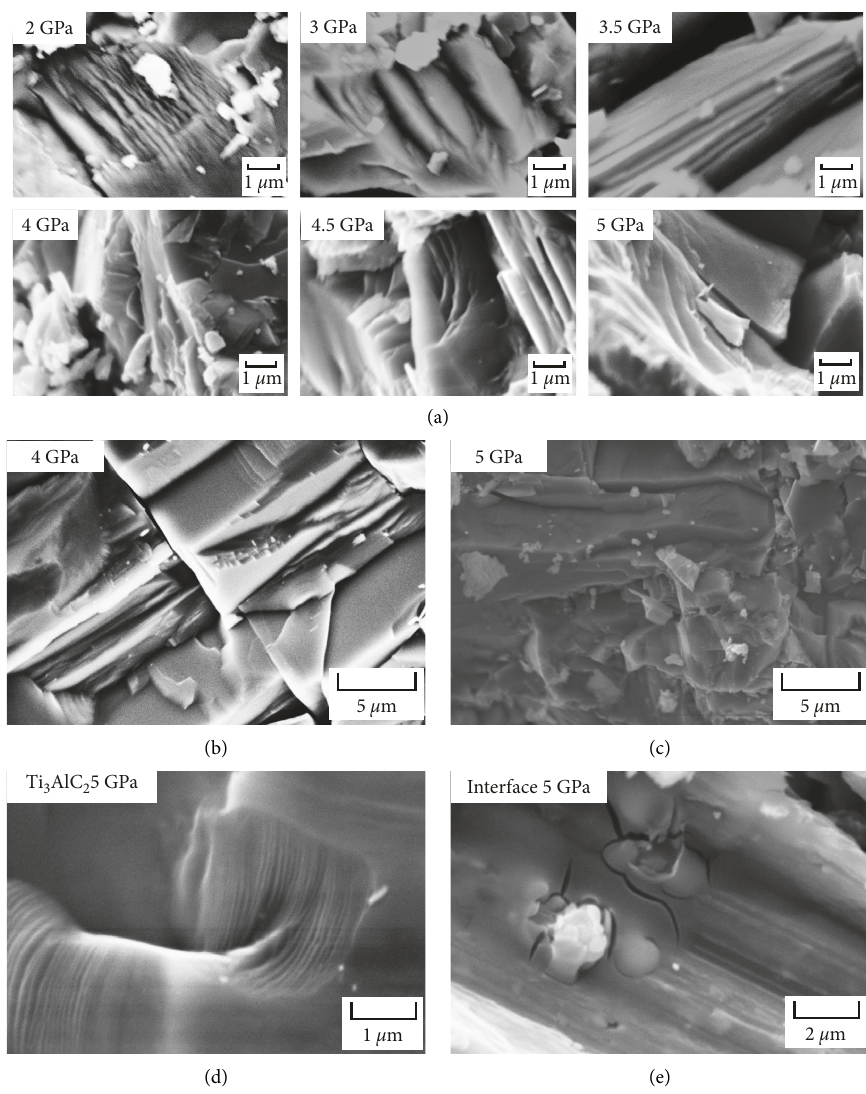
Figure 3: SEM micrographs of the layered structure of Ti 2 AlC/Ti 3 AlC 2 . (a) Synthetics prepared under 4GPa (b) and 5 GPa (c) high magnification of Ti 3 AlC 2 (d) interface of Ti 3 AlC 2 and TiC prepared under 5 GPa